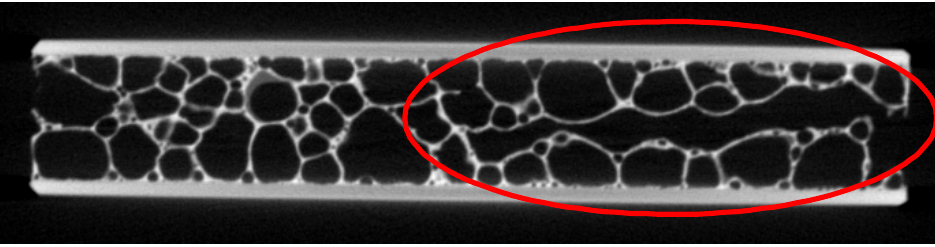
Figure 5. CT analysis of an AFS Schunk panel before the impact test